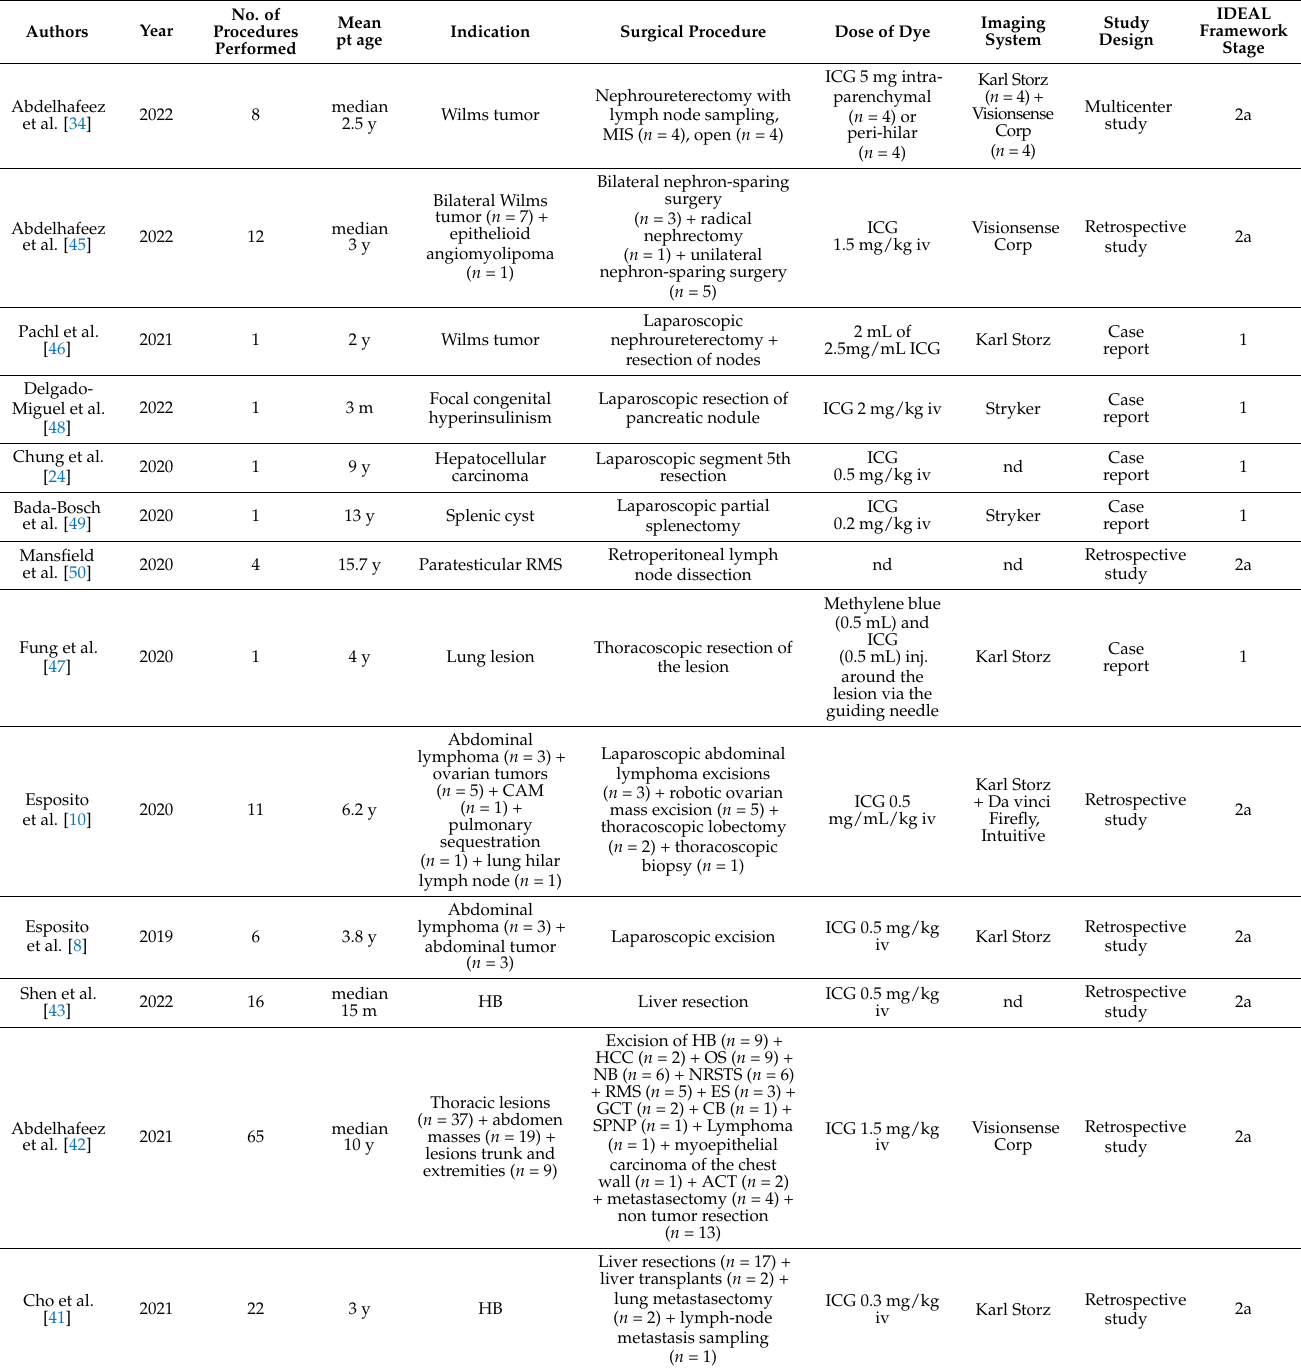
Table 4. Summary for tumor